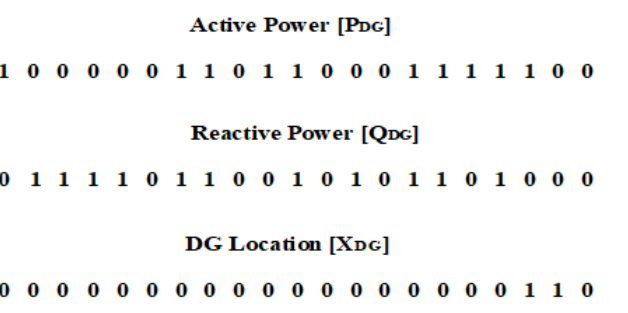
Figure 4. Final set of chromosomes for the optimal location and size of the new DG determined with the application of the GA.